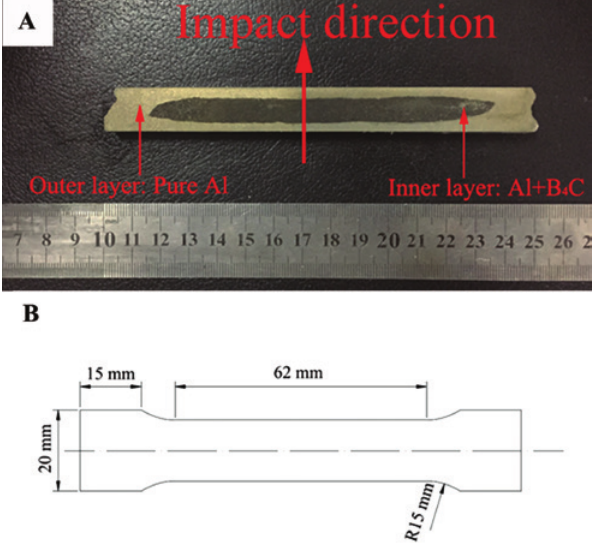
Figure 3: (A) The cross-section of the layered composite after hot rolling; (B) schematic of the tensile samples.